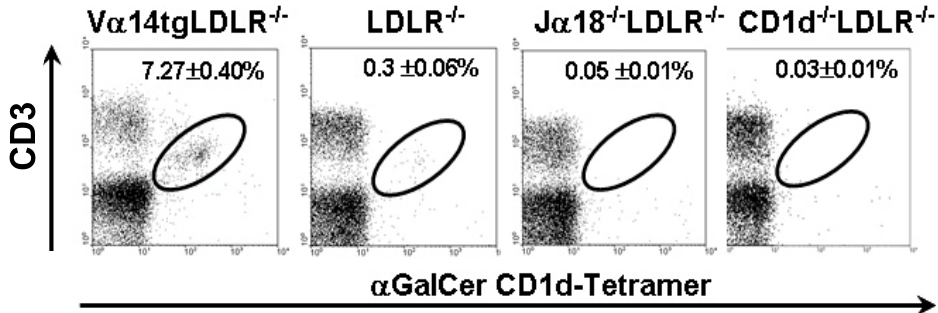
Figure 1. Flow cytometry analysis. Natural killer T (NKT) cell populations in the spleens from the indicated animal models fed Western type diet for 12 weeks were analyzed for CD3+ α-galactosyl ceramide (αGalCer) CD1d-Tetramer+ cells. n = 3–7 mice per group. Body weights of the WTD fed mice were similar between the strains (data not shown). The most consistent difference observed in the female mice was an increase of plasma cholesterol levels in the Jα18 −/− LDLR −/− mice (Figure 2A,B). This increase was reflected in higher VLDL and LDL cholesterol levels (Table 1). There was no difference in VLDL-TG production rates in female Vα14tg/LDLR −/− and Jα18 −/− LDLR −/− mice (Table 2) suggesting that the higher VLDL levels in the iNKT cell deficient mice may be due to reduced clearance rates. There were only modest differences in plasma lipids in male mice (Figure S1).